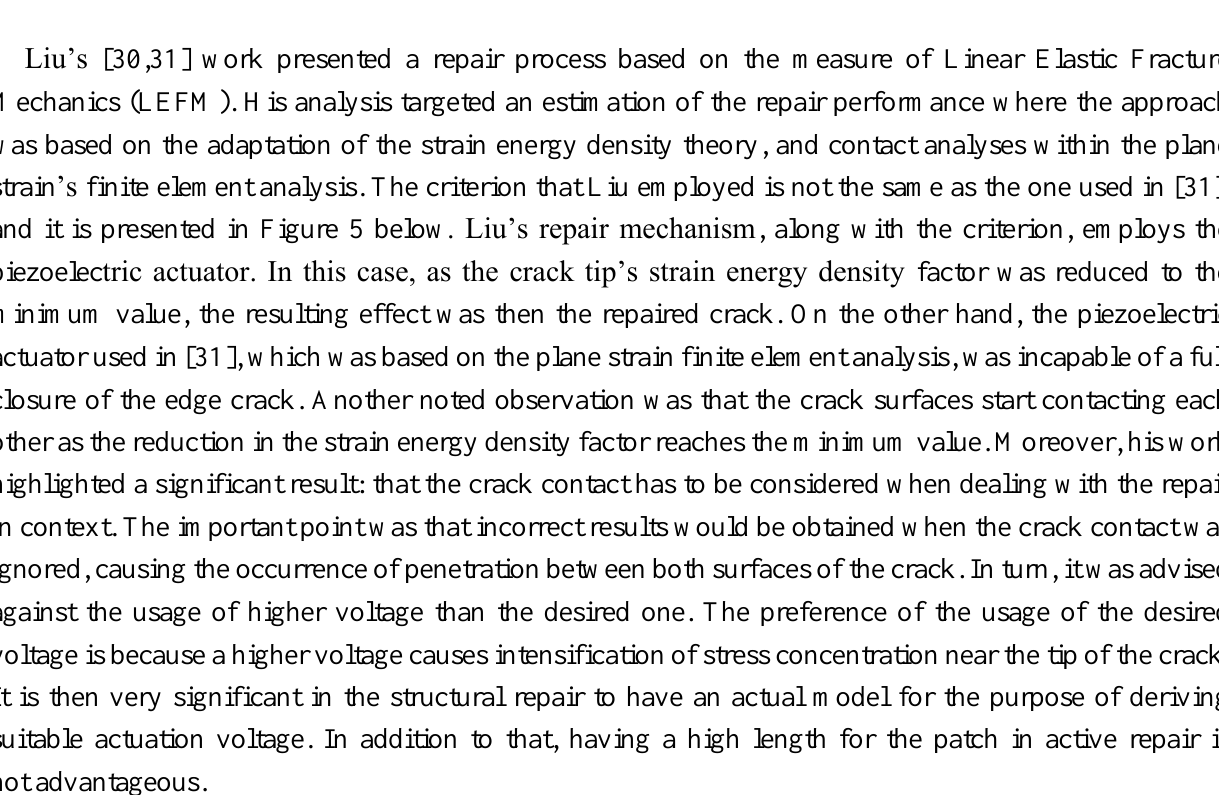
Figure 4 . Time history of tip displacement predicted by proposed model for ( a ) healthy beam, ( b ) cracked beam, ( c ) repaired beam, and ( d ) difference between repaired and healthy beam